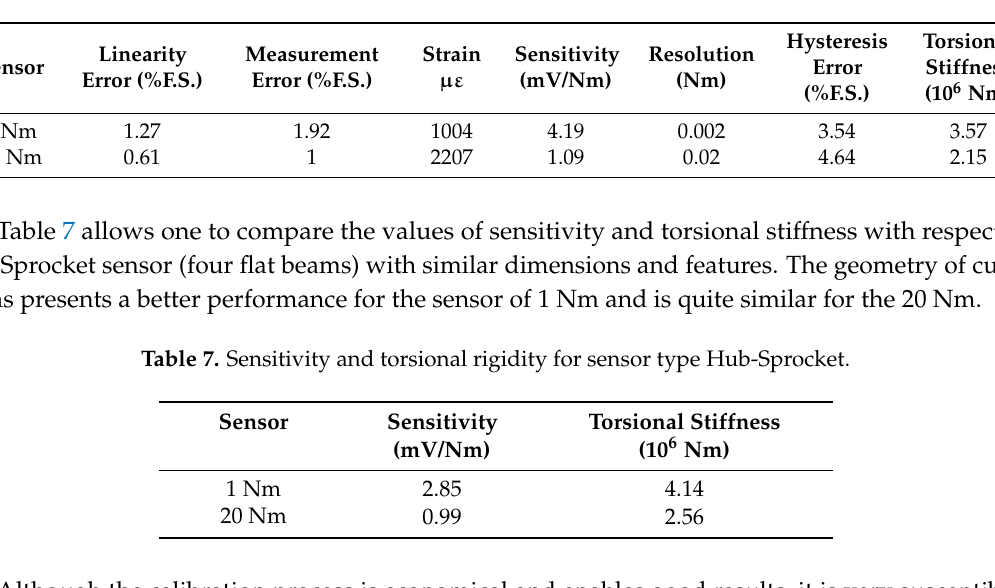
Table 6. Calibration results.